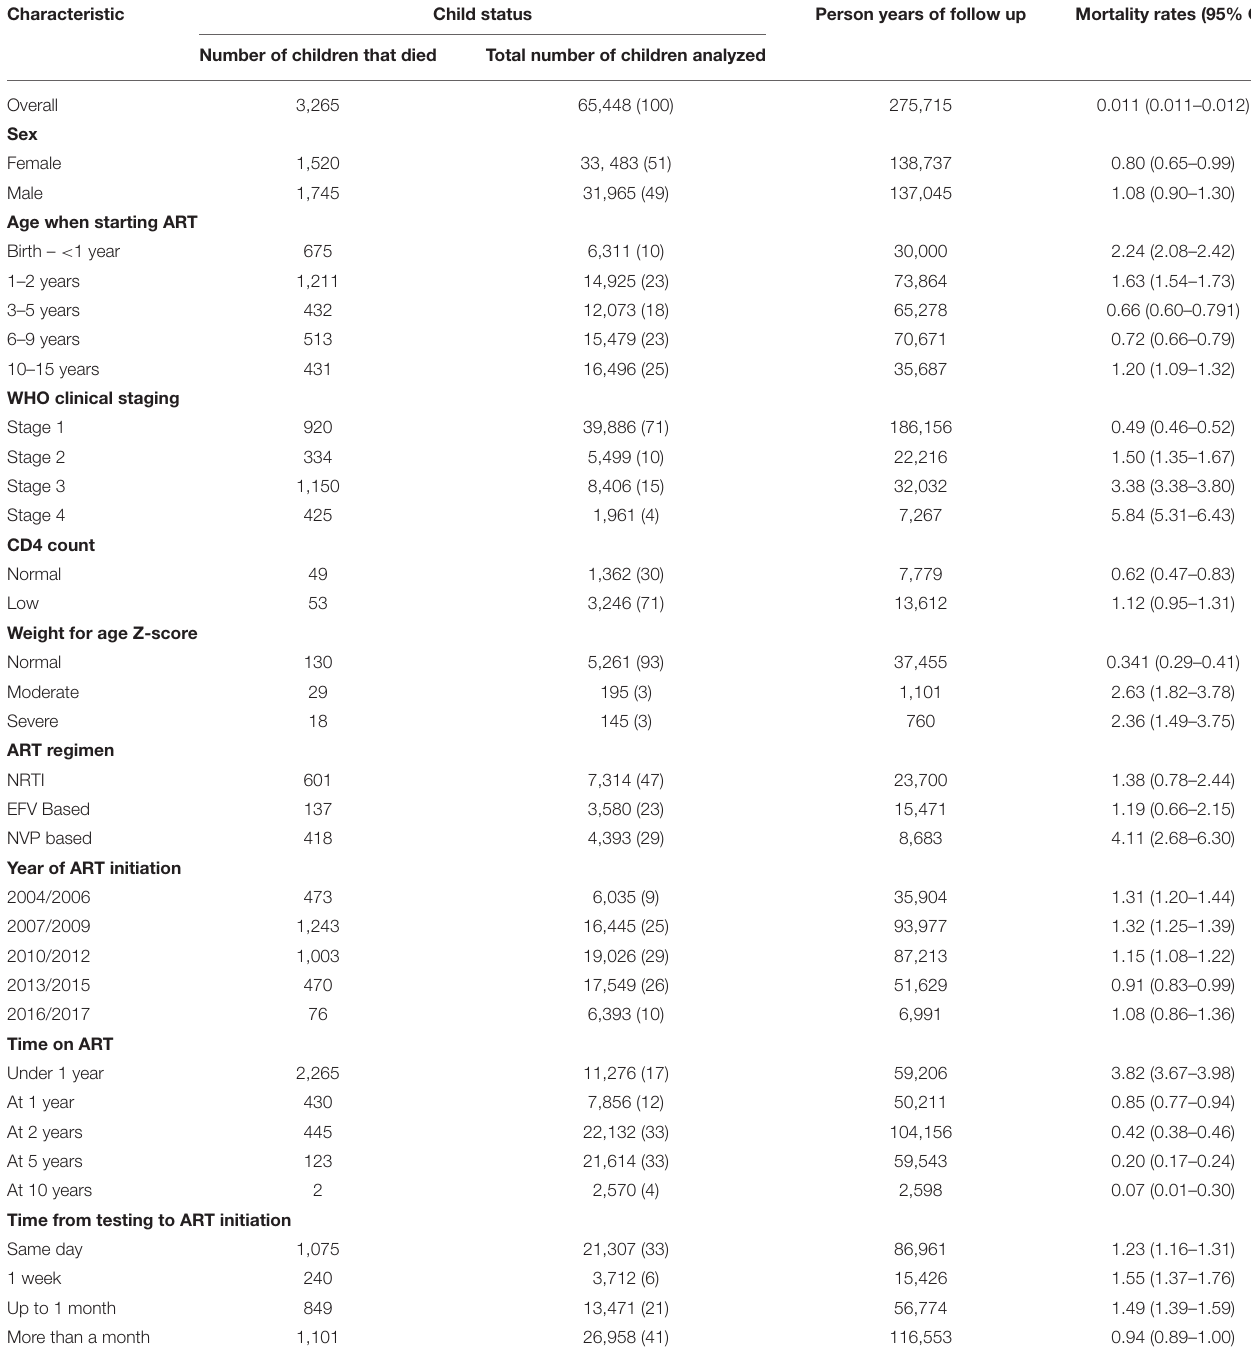
TABLE 1 | Background characteristics of CLHIV on ART in Zambia from 2004 to